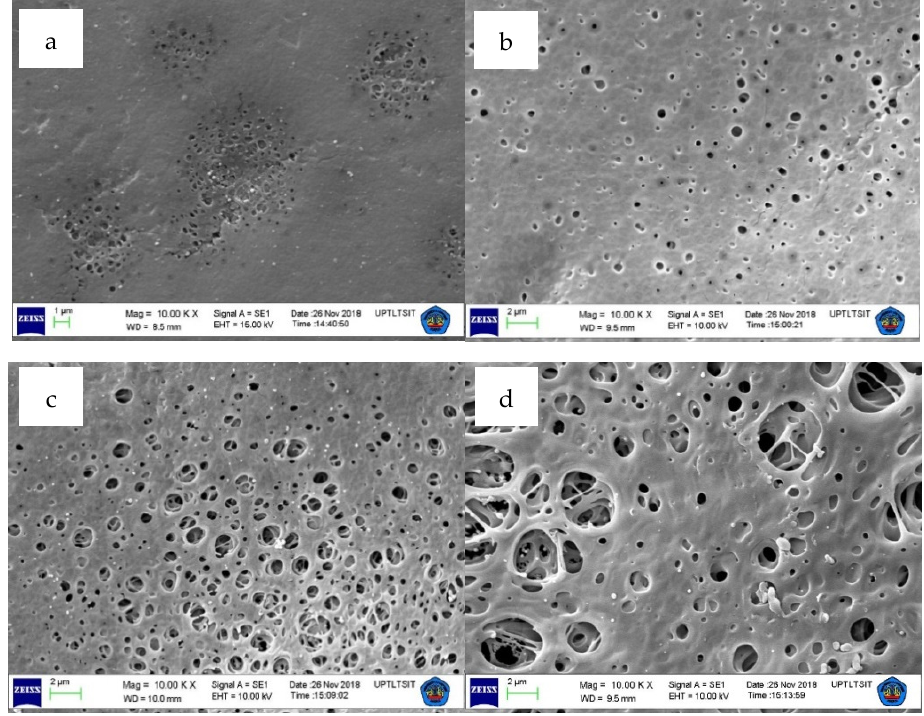
Figure 4. Surface morphological of ( a ) M0, ( b ) MA, ( c ) MB, and ( d ) MC membranes.